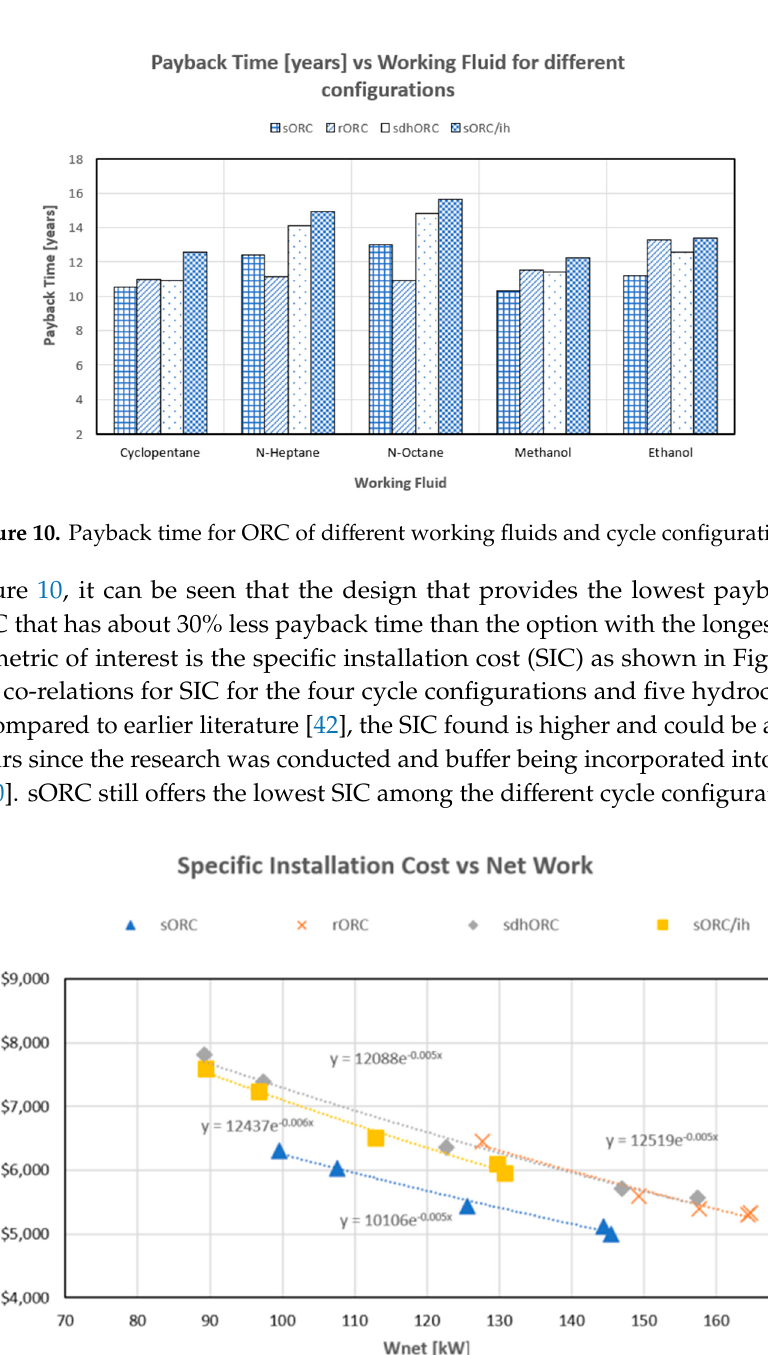
Figure 11. Specific installation cost for different cycle configuration.